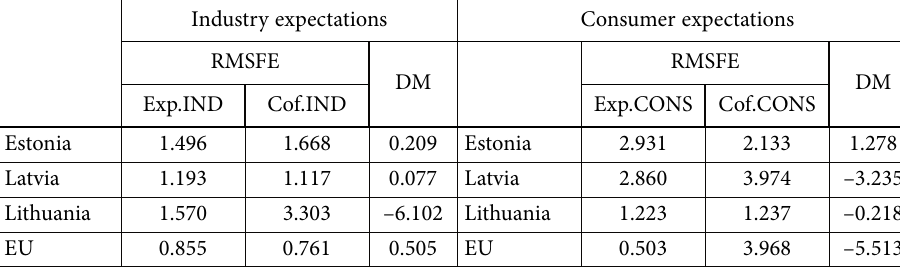
Table 3. Forecast accuracy – RMSFE and DM test Industry expectations